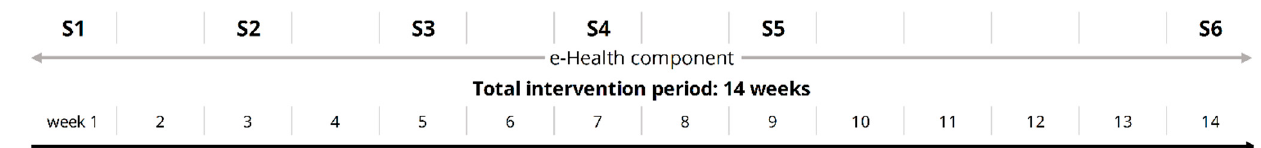
Figure 1. Timeline of the total intervention period.